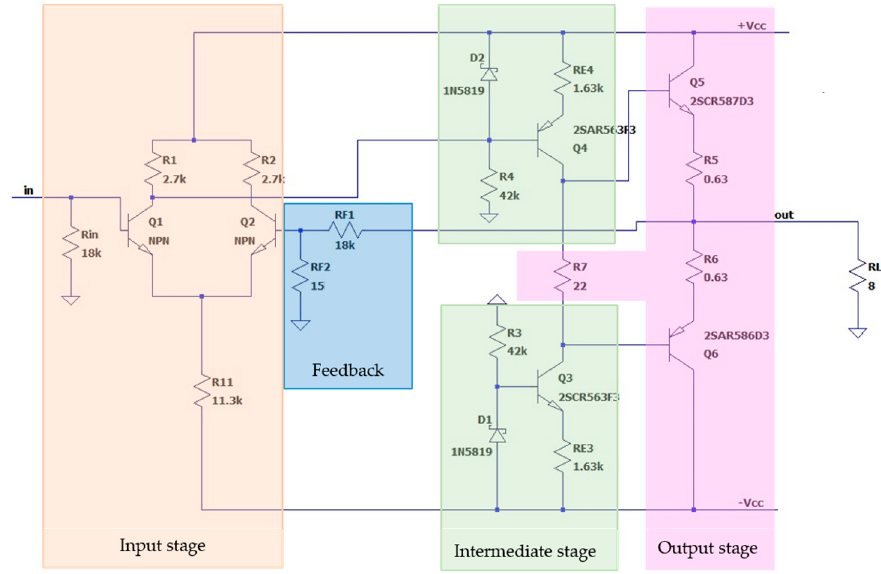
Figure 13. The constructed